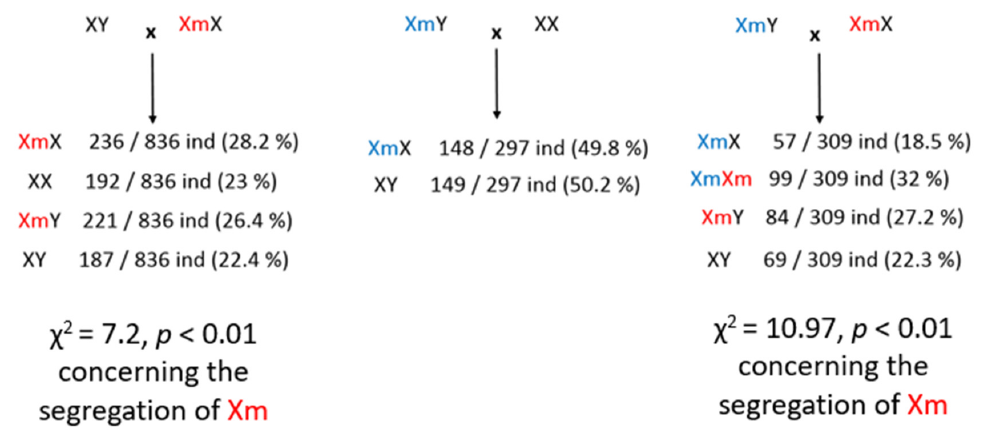
Figure 3. Details of the number of individuals obtained with different matings of the Arx dup24/0 mice bearing a duplication of 24 pb in the ARX gene located on chromosome X. These matings reveal a TRD for the transmission of the maternal X mutated (red Xm) allele, but not of the paternal (blue) Xm allele.